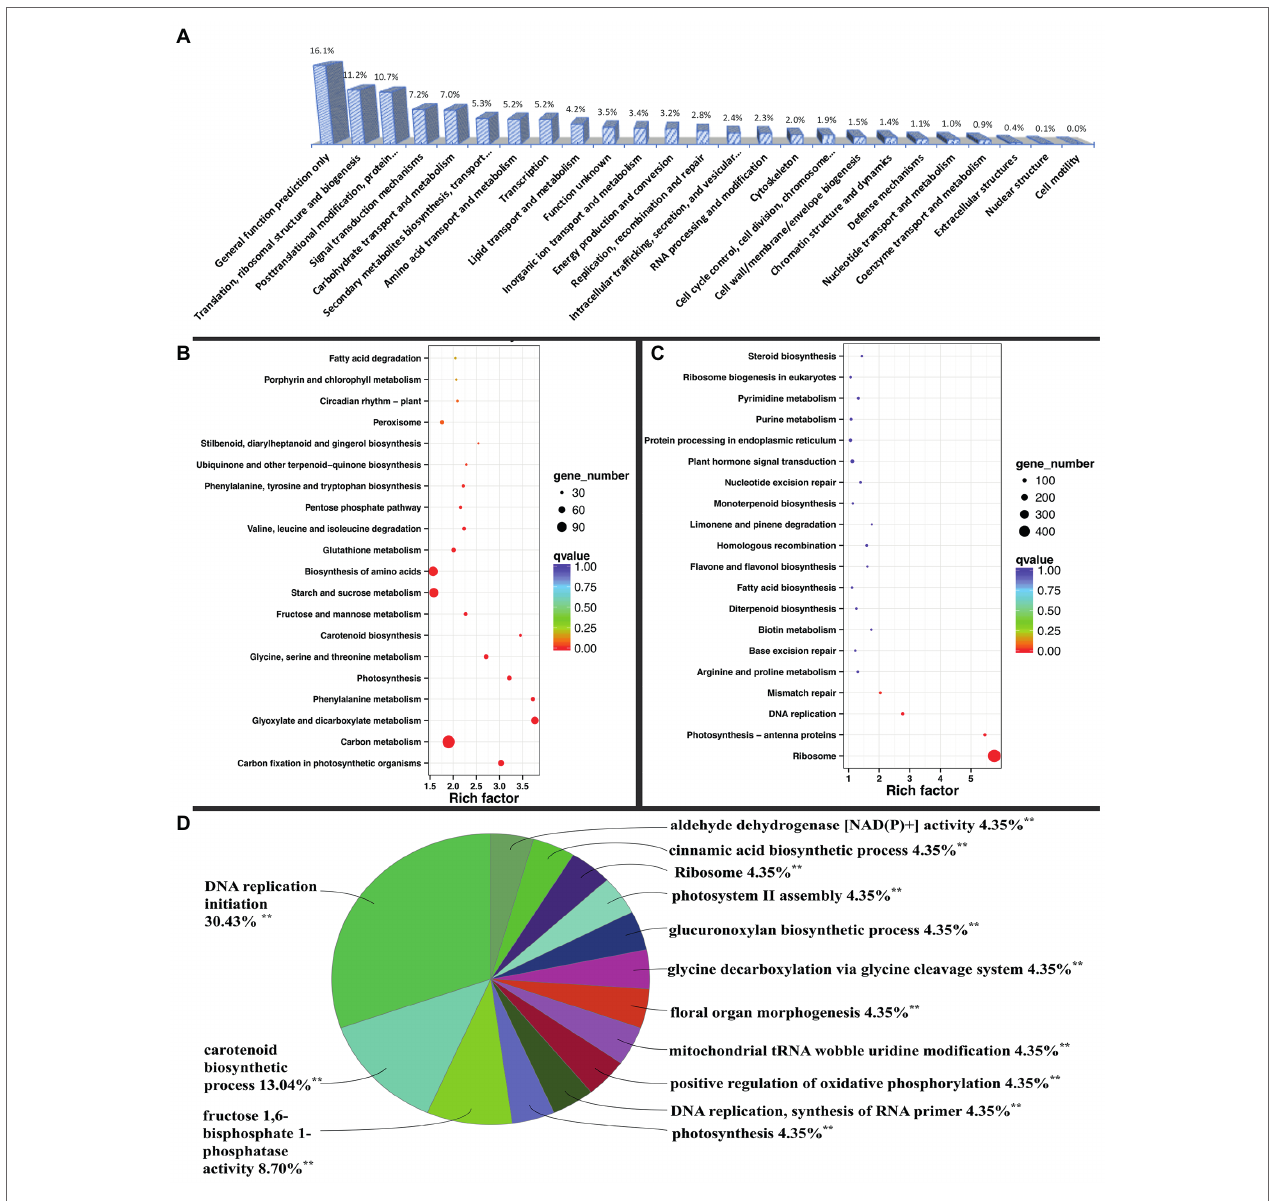
FIGURE 2 | KOG (Eukaryotic Orthologous Groups classification) and ClueGO grouping of differentially expressed genes and KEGG (Kyoto Encyclopedia of Genes and Genomes) pathway enrichment analysis. (A) KOG classification of DEGs. KEGG pathway enrichment of (B) up-regulated and (C) down-regulated DEGs. (D) DEG ClueGO grouping of terms or pathways, with percentage referring to the proportion of annotated terms to the total terms in each group. **Significantly